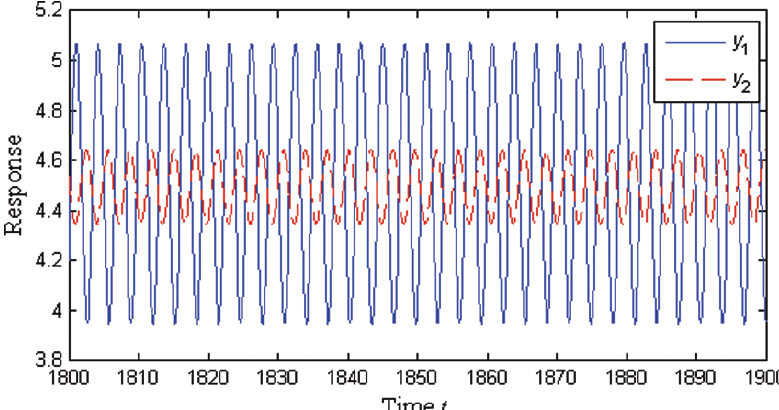
Fig. 15. Time history with feedback control, τ = 1.